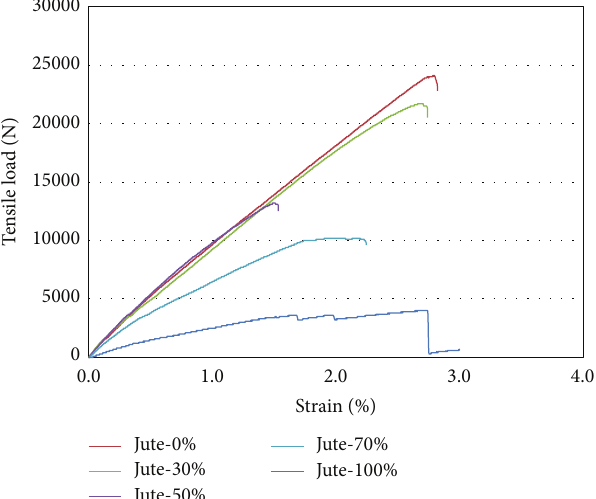
Figure 9: Tensile load-displacement behavior of HGJFRP compos- ite